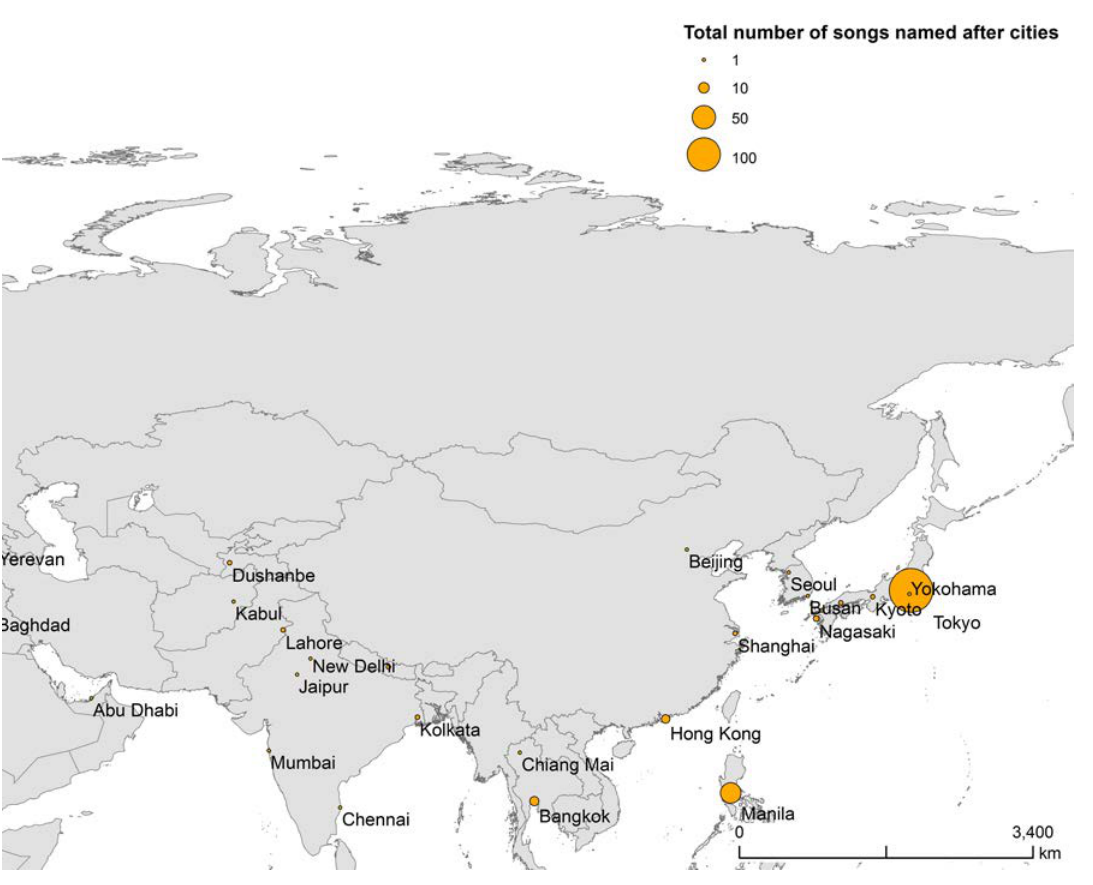
Figure 6: Songs named after cities in